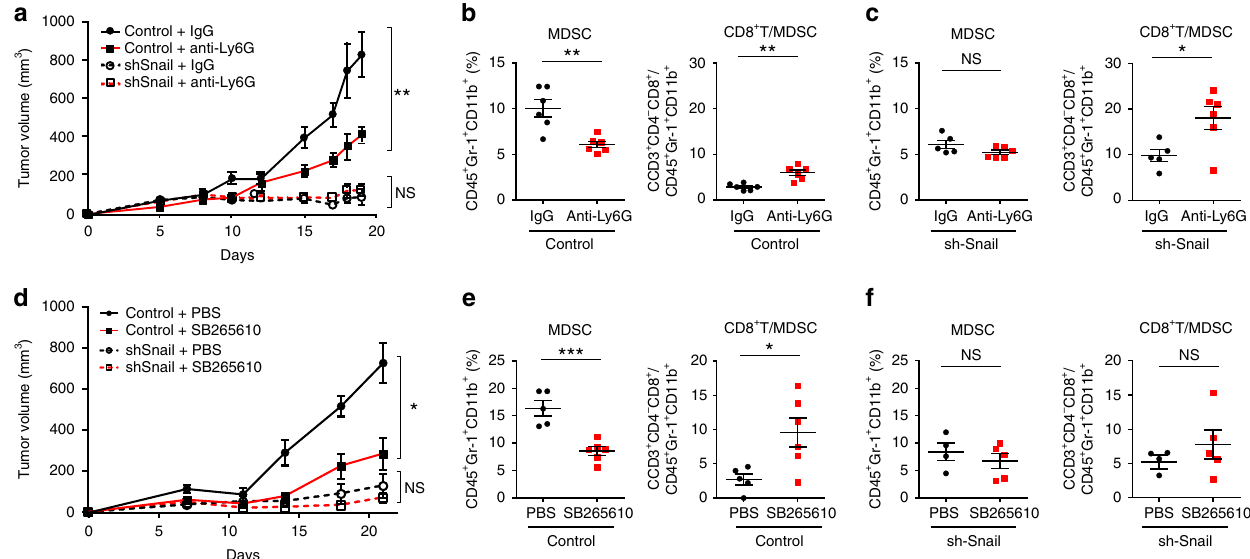
Fig. 7 A CXCR2 antagonist inhibits tumor progression by Snail. a Tumor growth in mice subcutaneously injected with HM-1-control cells or HM-1-shSnail cells, treated with anti-Ly6G antibody (400 µ g/body) or IgG twice a week from day 1 after tumor inoculation. P -values represent signi fi cance between two groups at day 19; n = 5 – 6. b Flow cytometric analyses of subcutaneous HM-1-control tumors treated with anti-Ly6G antibody or IgG at day 19. Percentage of positive cells relative to total cells is plotted. MDSCs (left) and CD8 + T cells/MDSCs (right); n = 6. c Flow cytometric analyses of subcutaneous HM-1- shSnail tumors treated with anti-Ly6G antibody or IgG at day 19. The percentage of positive cells relative to total cell count is plotted. MDSCs (left) and CD8 + T cells/MDSCs (right); n = 5 – 6. d Tumor growth in mice subcutaneously injected with HM-1-control cells or HM-1-shSnail cells, treated with SB265610 (2 mg/kg body weight) or PBS six times a week from day 1 after tumor inoculation. P -values represent signi fi cance between two groups at